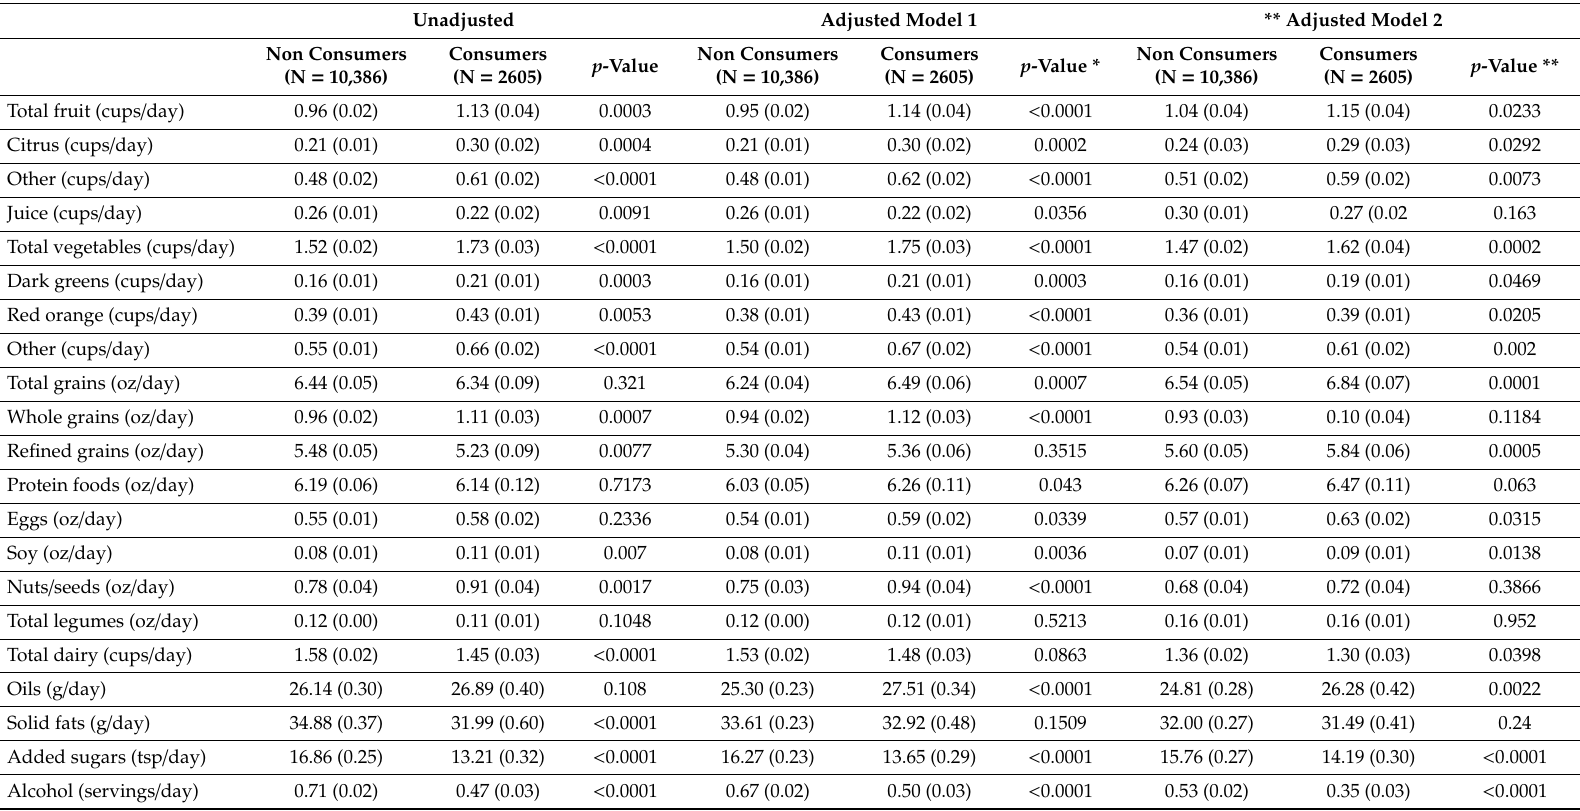
Table 5. Amounts of food groups consumed (units provided) among adult tea consumers and